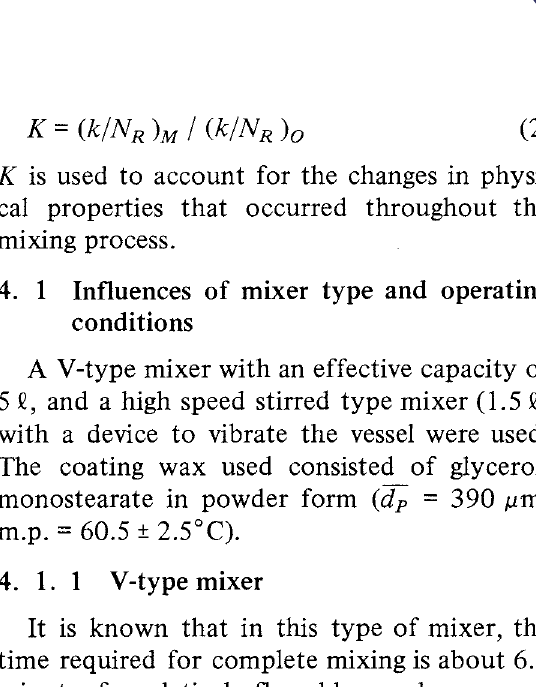
Fig. 7 Relationship between parameter k/N R and compressibility C